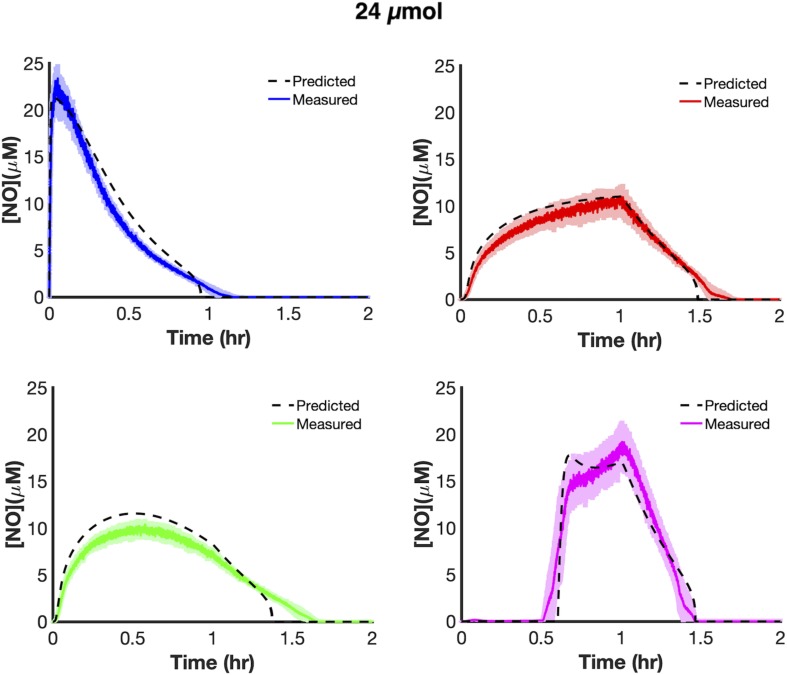
Model extrapolation and predictions at 24 μmol payloads. Dashed black lines represent predicted [NO] dynamics using the ensemble of parameter sets (ER < 10, 28 sets in total). Simulations from the ensemble members greatly overlapped, thus resembling a single line. Colored lines represent measured [NO] dynamics (bolus- blue; constant-red; ramp down-green; ramp up-pink). The solid lines represent the mean of three independent experiments, whereas the lightly shaded areas represent the standard error of the mean.